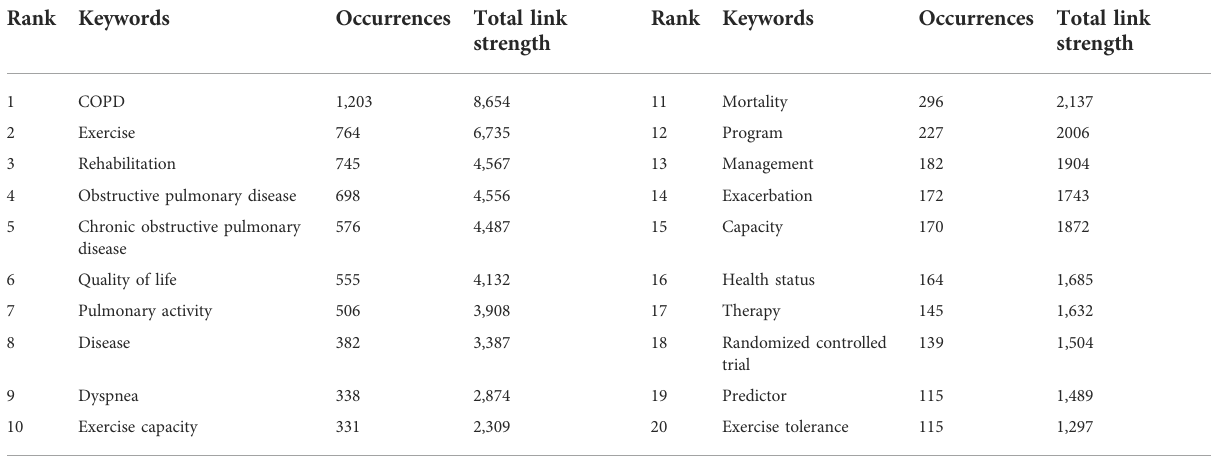
TABLE 7 The top 20 keywords in the studies of the COPD and exercise